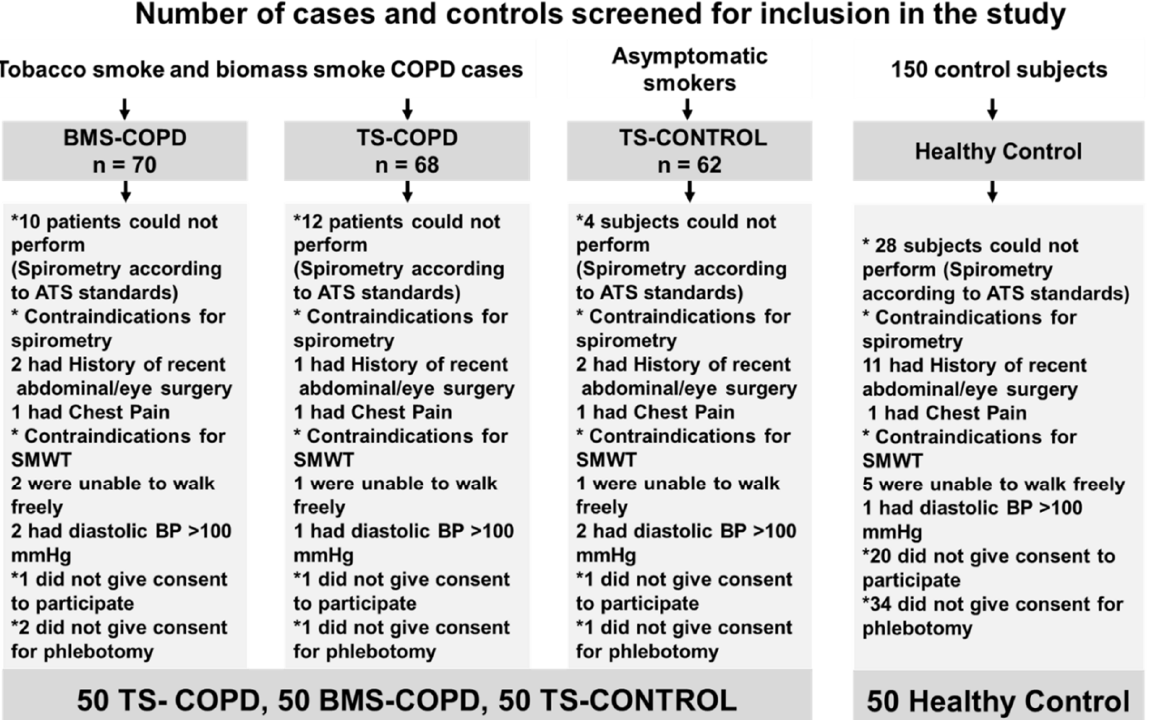
Figure 1. Inclusion and exclusion criteria of the study to select chronic obstructive pulmonary disease (COPD; both TS-COPD and BMS-COPD) subjects, asymptomatic smokers (TS-CONTROL), and healthy control subjects. ATS: American Thoracic Society, BMS-COPD: biomass smoke induced COPD, BP: blood pressure, SMWT: six-minute walk test, TS-COPD: tobacco smoke induced COPD. Table 1. Demography and clinical characteristics of the study cohort.